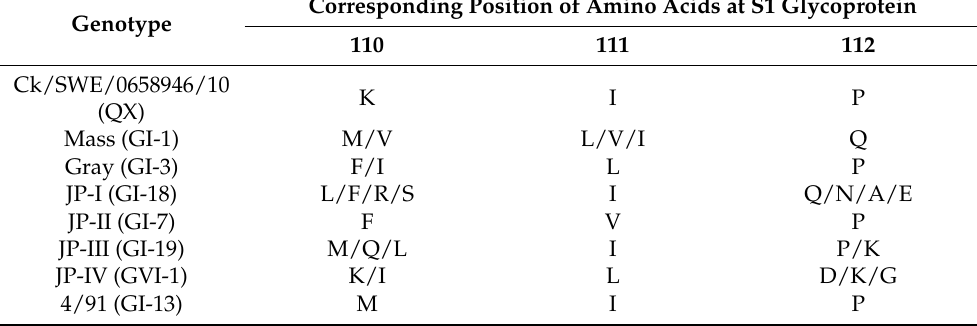
Table 4. Amino acids related to the kidney binding. Corresponding Position of Amino Acids at S1 Glycoprotein Genotype 110 111